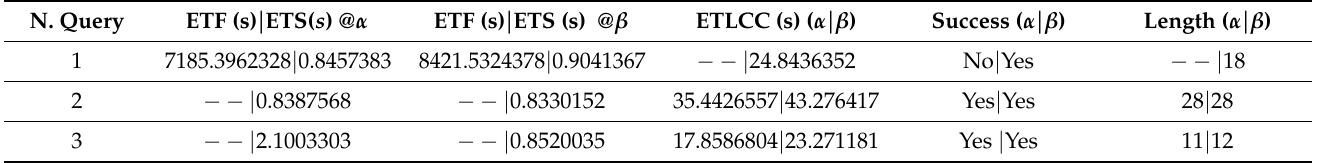
Figure 20. Collision-free path for a KUKA manipulator: MapleSoft visualization. Table 10. Execution time of case study 3 (KUKA 6 DOF manipulator). ETF: execution time spent for the incomplete LU factorization, ETS: execution time spent to solve linear system using ILU factors, ETLCC: execution time spent in the LCC algorithm, α : ILU tolerance = 1 × 10 − 6 , and β : ILU tolerance = 1 × 10 − 9 . N.